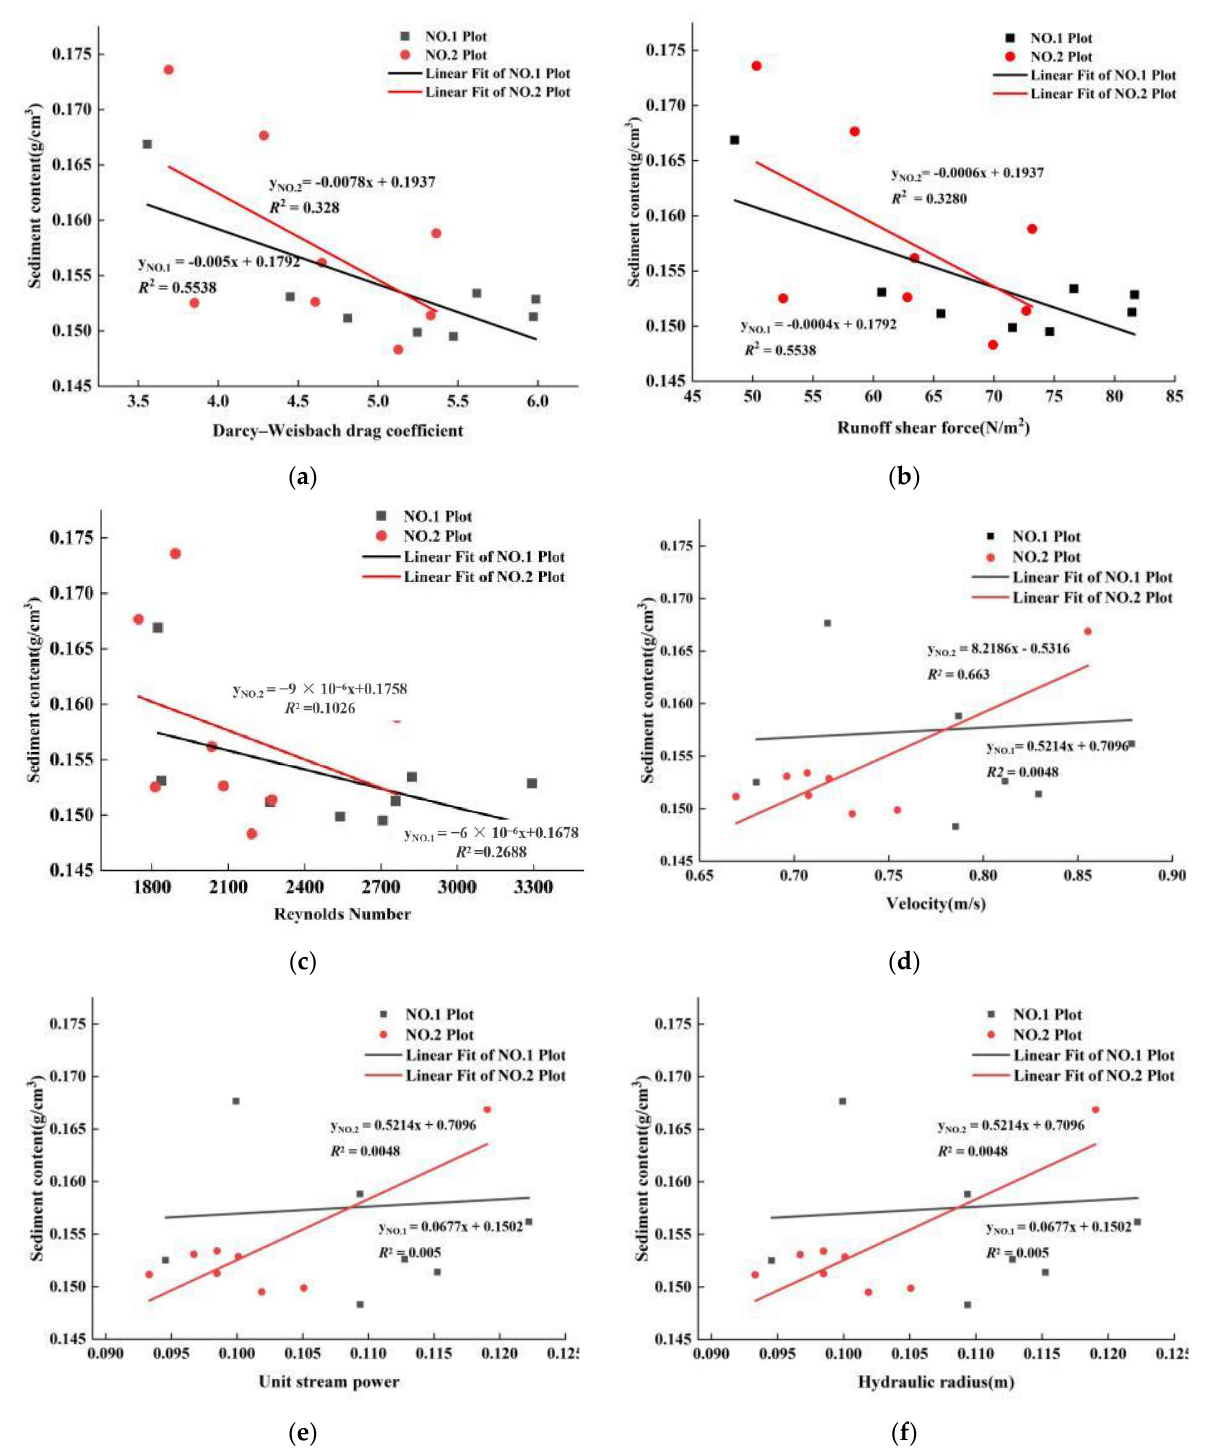
Figure 10. The relationship between mean sediment content (CS) and mean Darcy-Weisbach